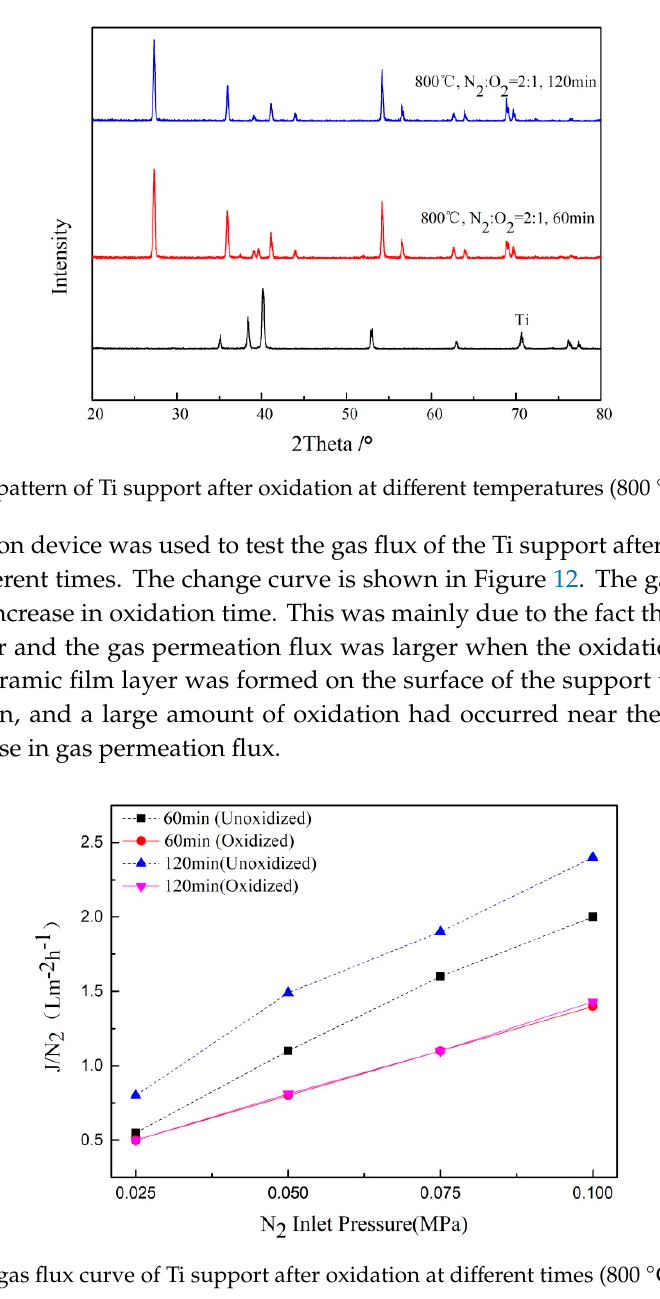
Figure 12. The gas flux curve of Ti support after oxidation at different times (800 °C, N 2 :O 2 = 2:1).